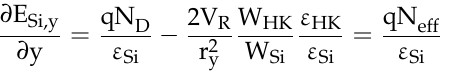
Figure 2. Schematic cross-section view and E-field component profiles of VHK LDMOS. According to the Poisson equation and dielectric RESURF [17–20], the vertical E-field component (E Si,y ) is modified by the effective doping concentration Neff of semiconductor, which can be expressed as